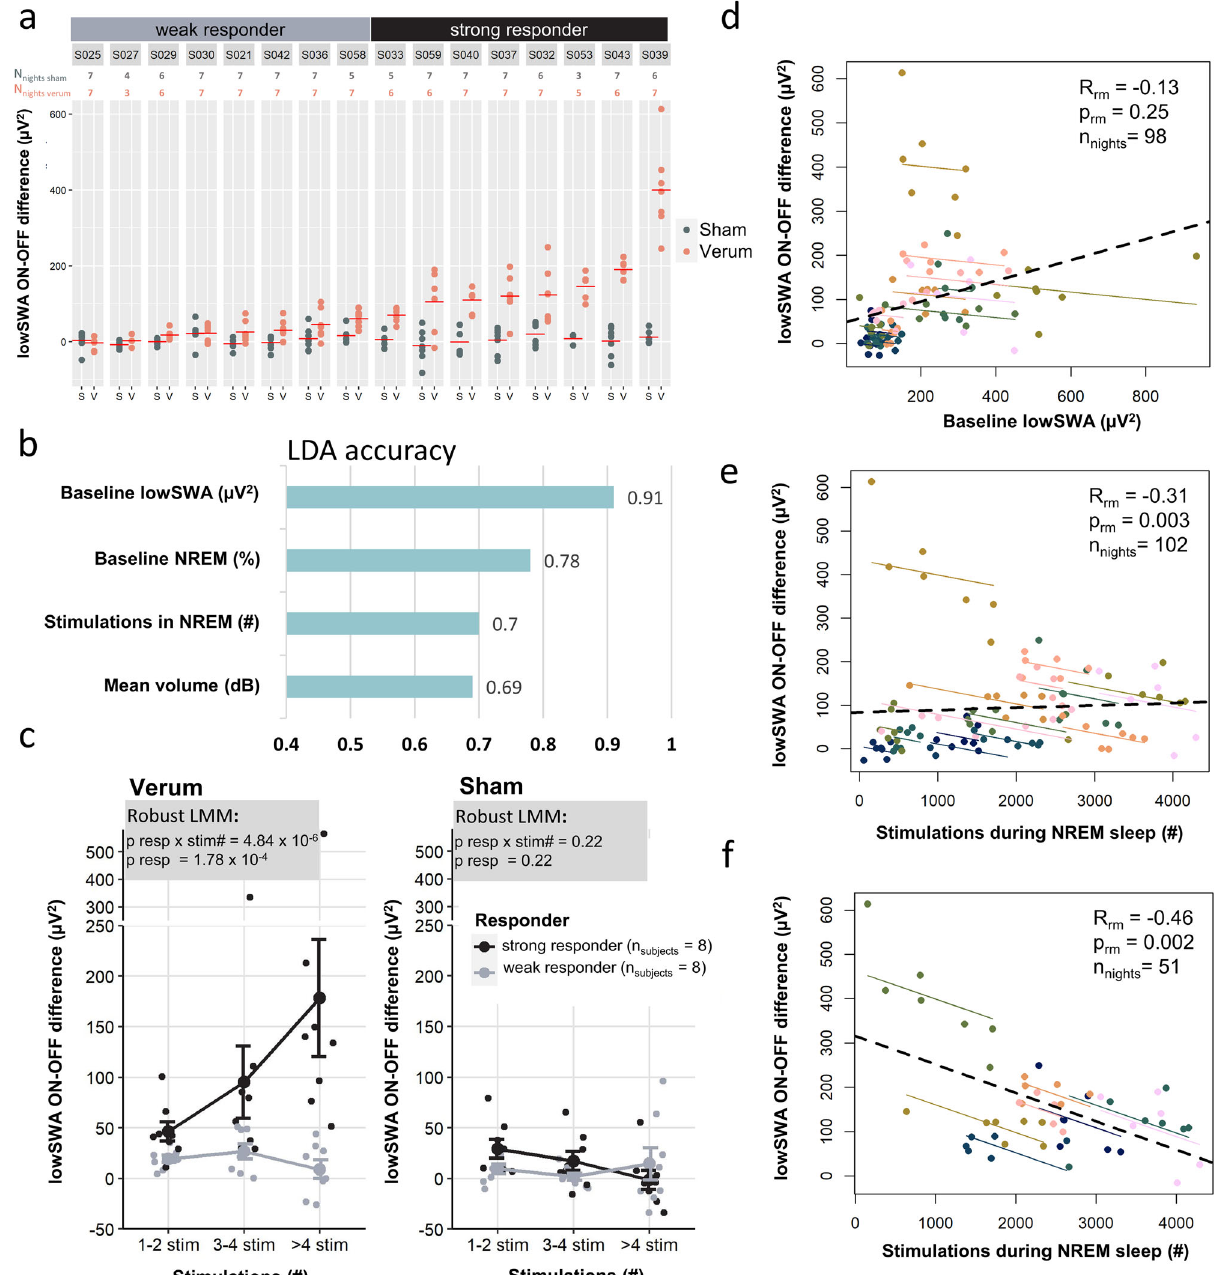
Fig. 3 Predictive factors for across and with subject variability in ON-OFF difference in low-frequency slow wave activity (lowSWA) during the windowed approach. a Individual (all nights of n subjects = 16) ON-OFF difference (calculated using ON-OFF analysis, see methods) of lowSWA for all windows with >2 stimulations sorted by averaged lowSWA (red horizontal lines) during Verum. Strong responders refer to the upper 50% and weak responders to the lower 50% of participants. Clear ON-OFF differences during Verum condition across the majority of nights are seen for strong responders but not that clearly for weak responders. (S = Sham, V = Verum). b Linear discrimination analysis (LDA) using 10-fold cross-validation. All good quality nights during Verum ONOFF were included in the model and labeled as weak or strong responder night (dependent variable for classi fi cation). For lowSWA and %NREM N3 (non-rapid eye movement stage 3) during baseline, number of stimulations during NREM sleep and mean sound volume (prediction factors) a separate LDA model was run and accuracy in predicting weak and strong responder nights were plotted in blue. * indicate p < 0.05 comparing accuracy achieved by the prediction factors to chance level (No Information Rate). c Comparison of lowSWA ON-OFF difference between weak and strong responder (factor resp) for windows that only included sound volume at 52 dB (baseline lowest level) and for different stimulation bins (factor stim#) using a robust linear mixed-effect model (LMM) illustrated as error bars (mean ± SEM) with data points representing individual participants. The y - axis has been condensed to better visualize the error bars despite outliers. d – f Repeated measures (rm) correlations to investigate the prediction of nightly lowSWA ON-OFF difference variance. d Predictor baseline lowSWA for all good quality Verum ONOFF nights. e Predictor number of NREM sleep stimuli for all good quality Verum ONOFF nights. f Predictor number of NREM sleep stimuli for all good quality Verum ONOFF nights in strong responder subjects. Data underlying this fi gure is provided in Supplementary Data